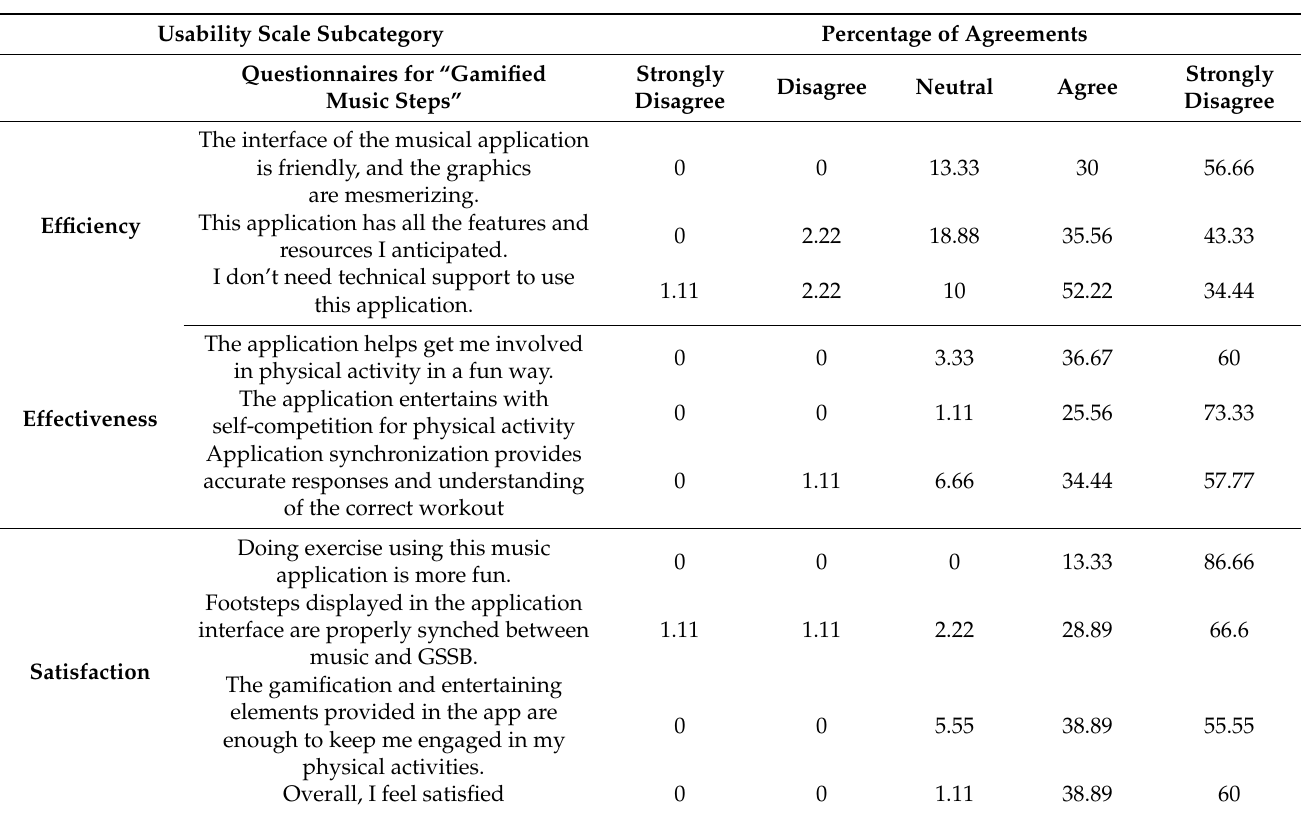
Table 3. Usability scale questionnaires average responses of SSB for N =